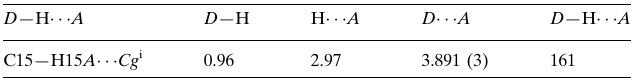
Symmetry code: (i) x (cid:3) 1 ; y ; z . Cg is the centroid of the C2–C7 benzene ring. Data collection: SMART (Bruker, 2001); cell refinement: SAINT (Bruker, 2001); data reduction: SAINT ; program(s) used to solve structure: SHELXS97 (Sheldrick, 1997); program(s) used to refine structure: SHELXL97 (Sheldrick, 1997); molecular graphics: ORTEP-3 (Farrugia, 1997) and DIAMOND (Brandenburg, 1998); software used to prepare material for publication: SHELXL97